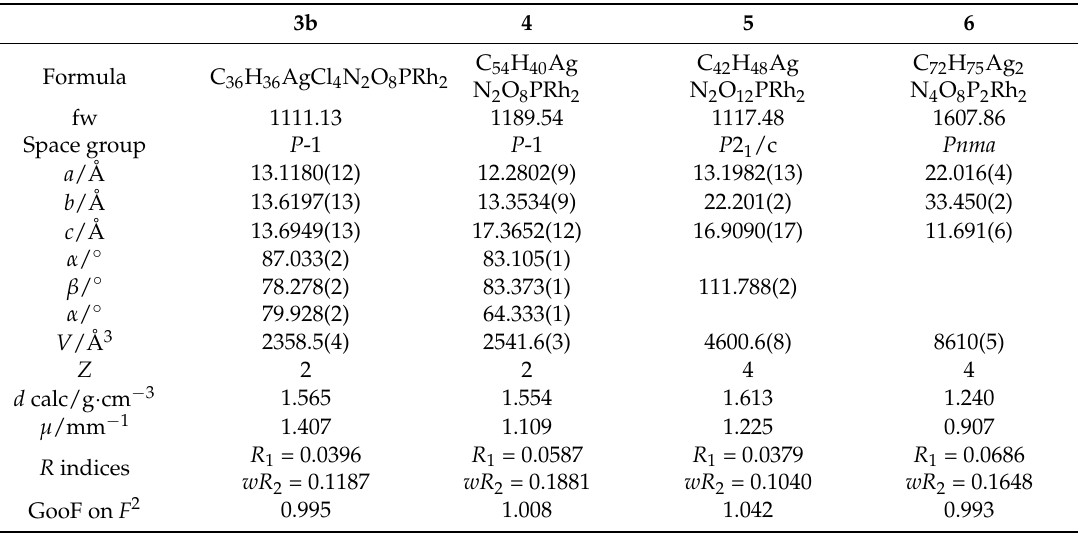
Table 2. Crystal and refinement data for 3b and 4 –